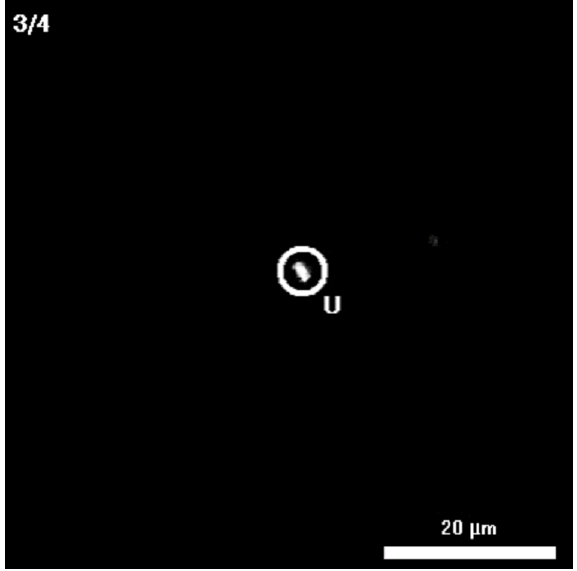
Fig. 5 BEI picture of the U-rich particle originating from Unit 3 of NPP